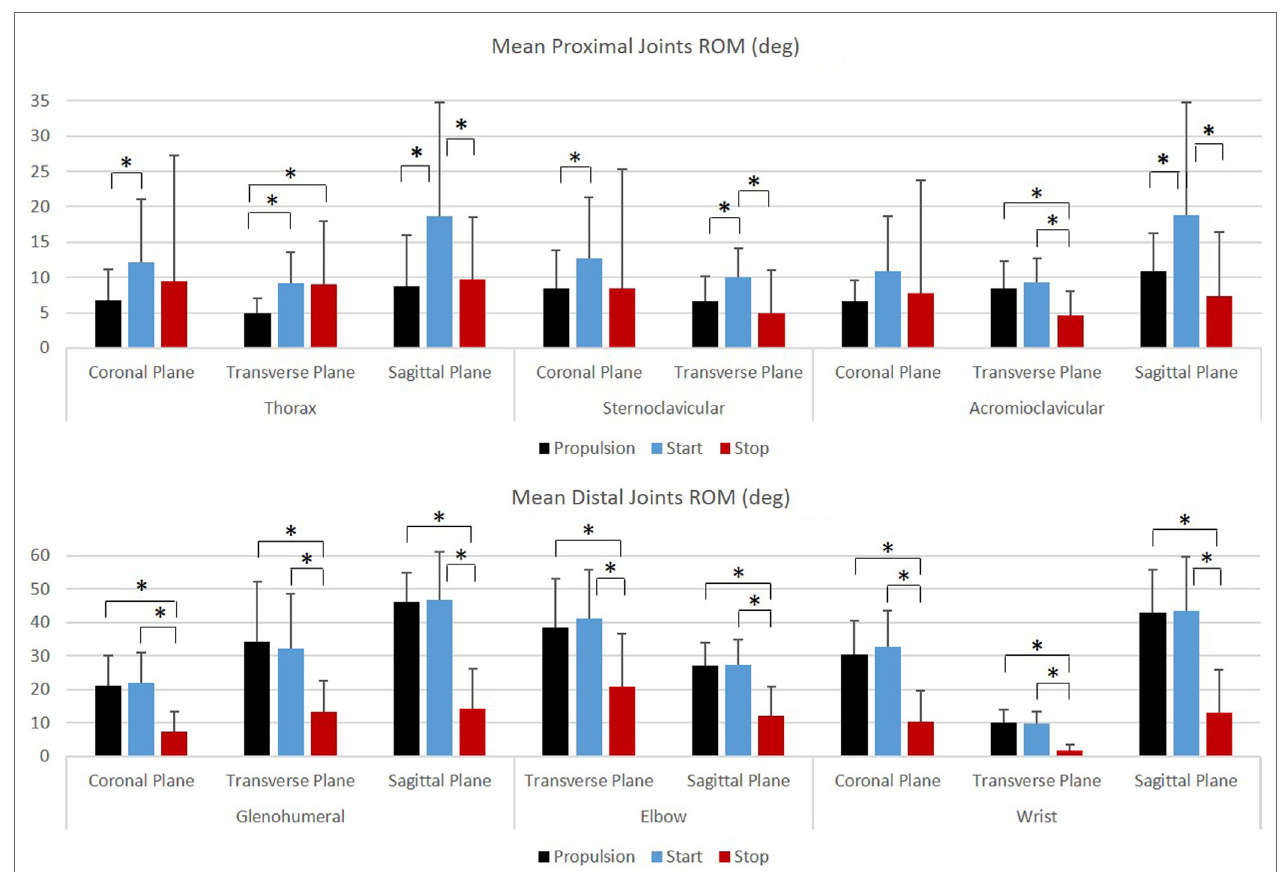
FigUre 7 | group mean joint ranges of motion (degrees) for the proximal joints (top row: thorax, sternoclavicular, and acromioclavicular) and the distal joints (bottom row: glenohumeral, elbow, and wrist) during each functional mobility task, propulsion (black), start (blue), and stop (red) . One SD is represented by the thin vertical bar. Tasks connected by an asterisk are statistically significantly different ( p <